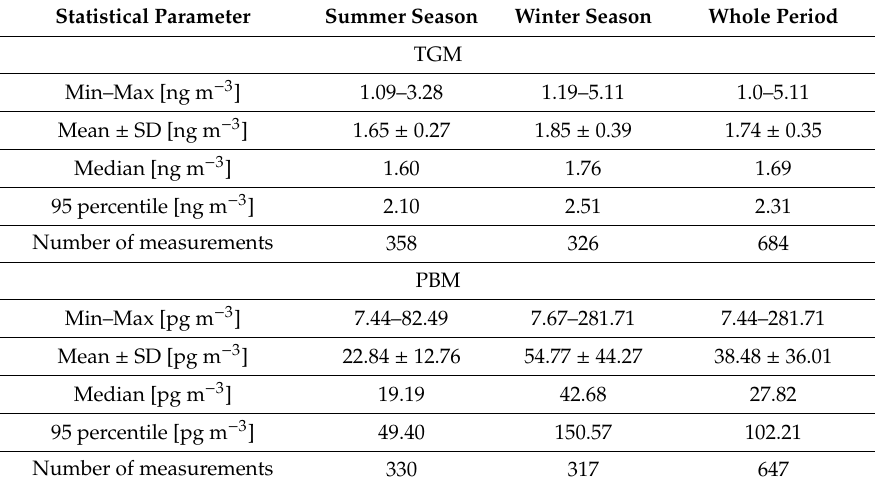
Table 2. Descriptive statistics of the measurement results (24 h concentrations) of total gaseous mercury (TGM) and PM 2.5 -bound mercury (PBM) at the rural background station in Złoty Potok,